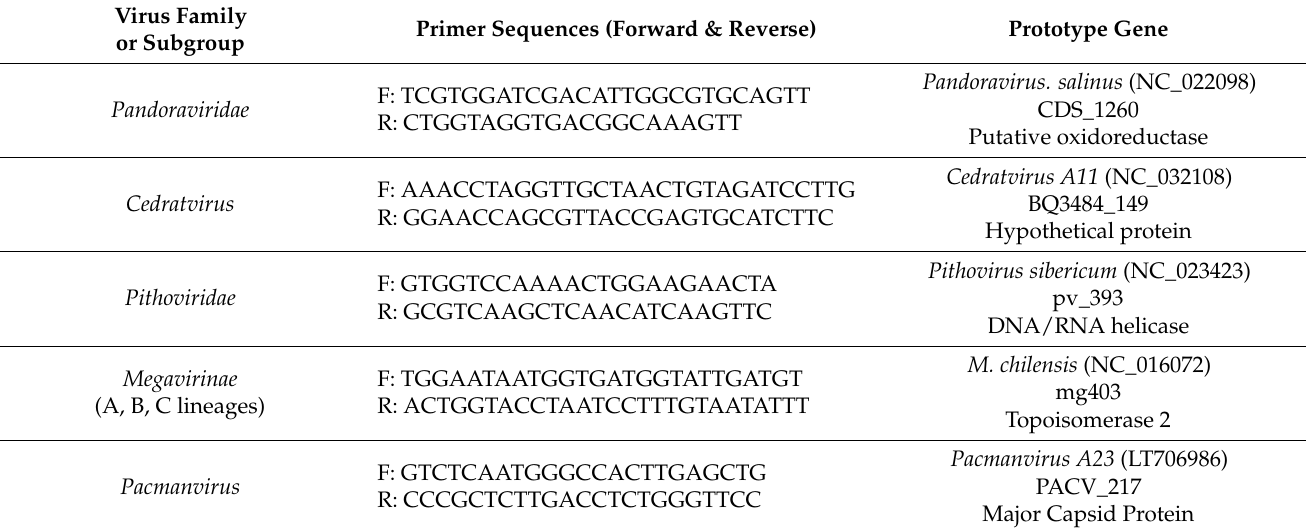
Table 2. PCR primers used to identify the newly isolated